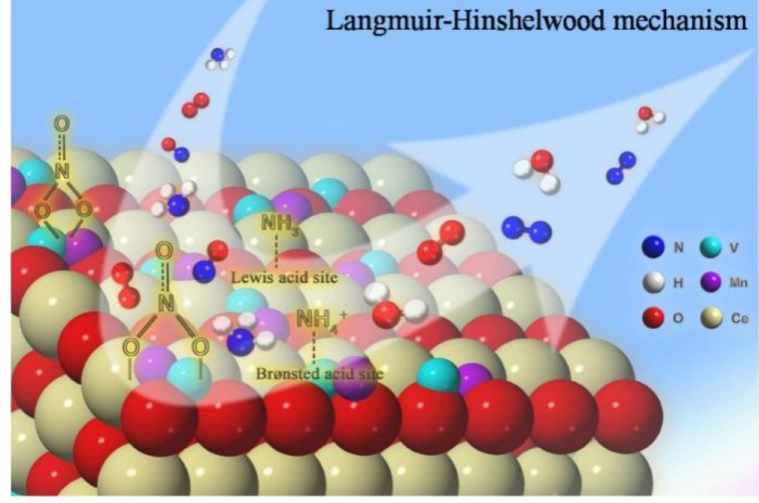
Figure 9. The possible mechanism of the VO x -MnO x /CeO 2 catalyst. Reproduced with permission from Reference [30]; copyright (2020),